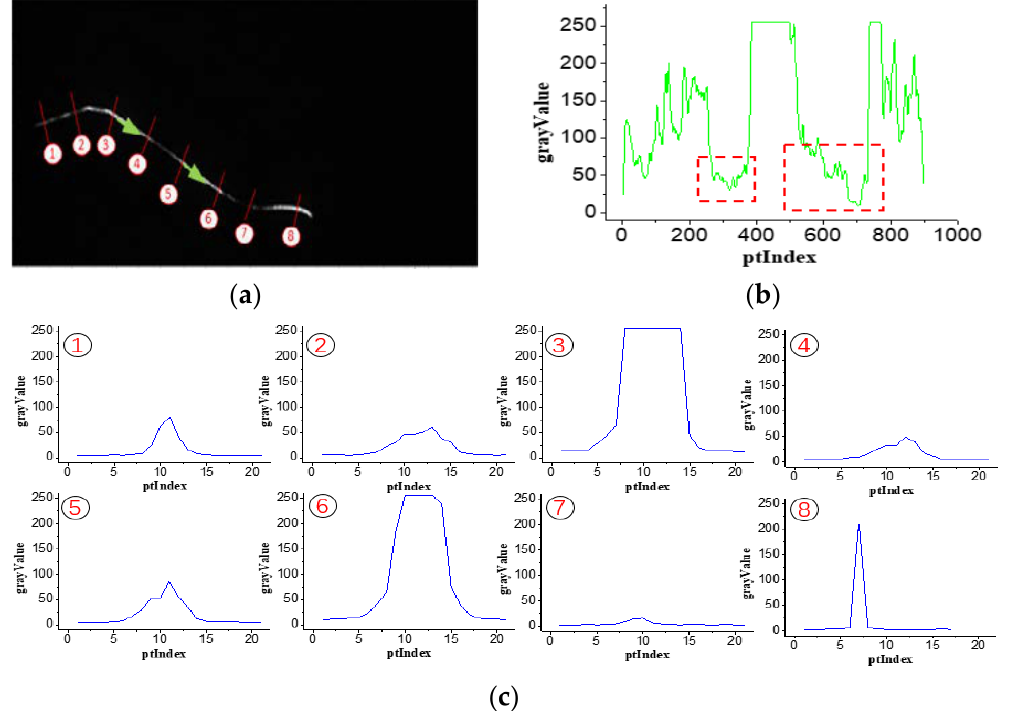
Figure 5. Gray distribution of the stripe image in the stripe and normal directions. ( a ) Stripe image from the outer camera. ( b ) Gray value distribution in the stripe direction. ( c ) Gray distribution curves of the stripe image in the normal direction.